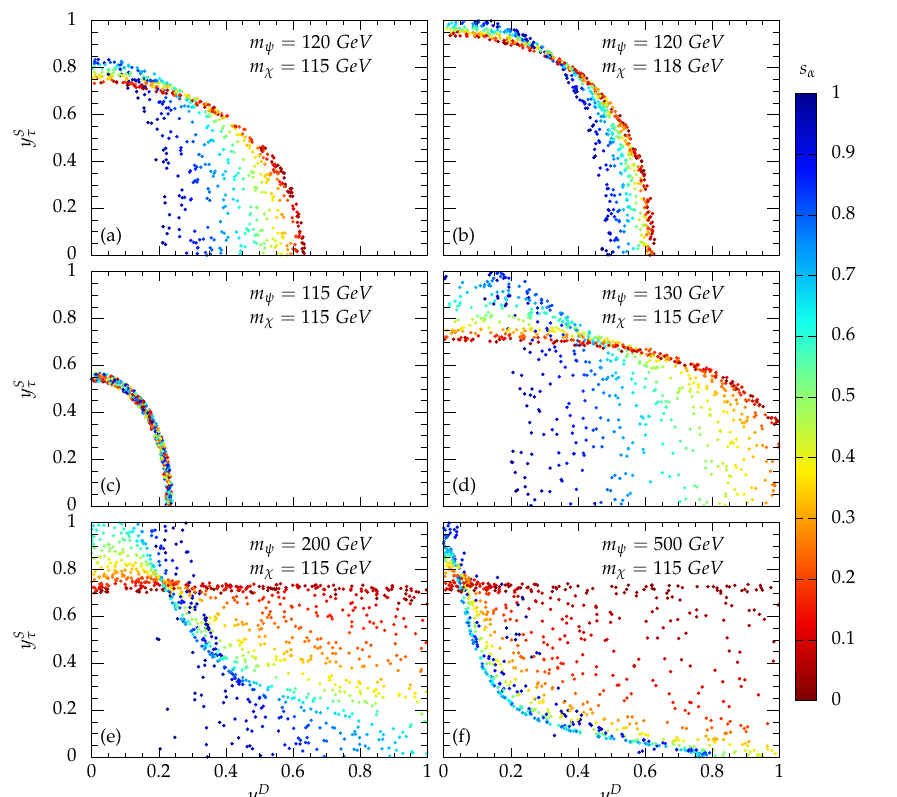
Figure 4 . y D vs y S correlation for relic density allowed points. For fixed DM mass, the variation τ τ of the charged dark fermion masses and mixing angle substantially changes the correlation. m φ is fixed at 100